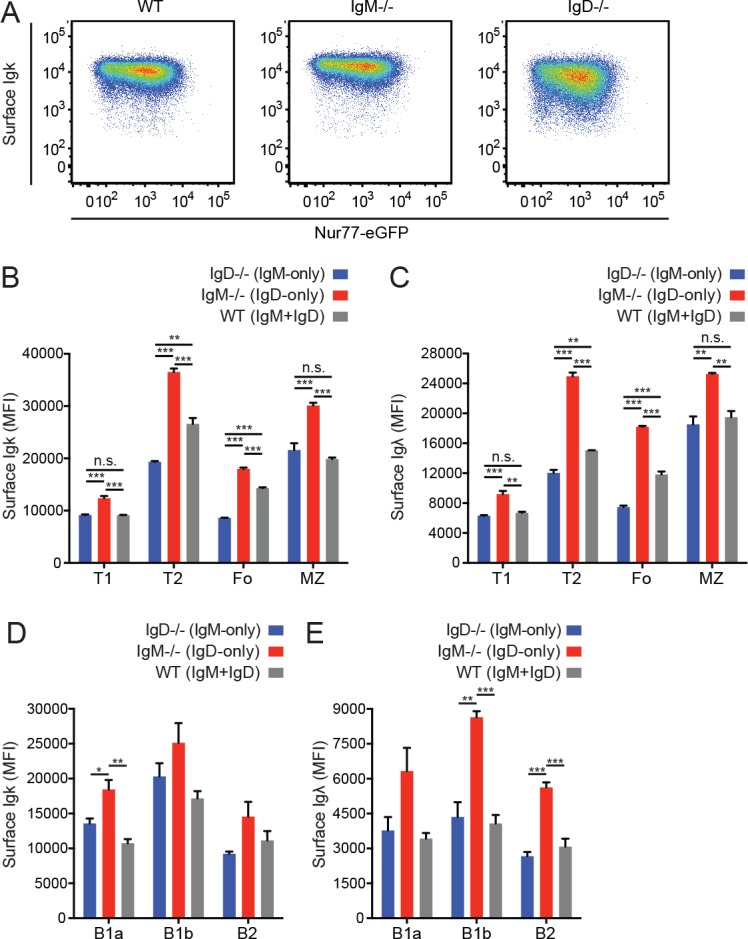
Quantification of surface BCR expression on B cell subsets.(A) Surface Igκ expression relative to Nur77-eGFP reporter in Fo B cells from WT, IgM−/−, and IgD−/− mice. (B) Mean surface Igκ expression was calculated for Igκ+ splenic B cell (B220+) subsets in WT, IgM−/−, and IgD−/− mice. T1 (CD93+CD23-); T2/3 (CD93+CD23+); Fo (CD93-CD23+); MZ (CD21hiCD23lo). (C) Surface Igλ MFI of Igλ+ B cell subsets described in (B). (D) Surface Igκ MFI of Igκ+ cells in peritoneal B cell (CD19+) subsets. B1a (CD5+CD23-); B1b (CD5-CD23-); B2 (CD5-CD23+). (E) Surface Igλ MFI of Igλ+ cells in peritoneal B cell subsets described in (D). Data in (A) are representative of n = 3 independent experiments. Values in (B-E) were calculated from n = 3 mice of each genotype. One-way ANOVA with Tukey’s multiple comparisons test (B-E) was used to calculate p values, and mean +SEM is displayed. *p<0.05, **p<0.01, ***p<0.001.